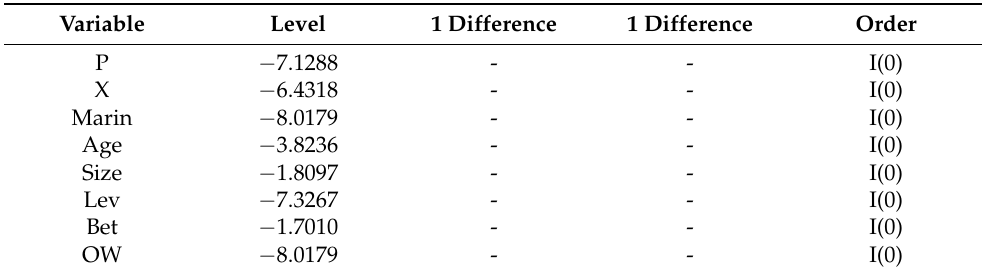
Table 5. Stationarity URT test of